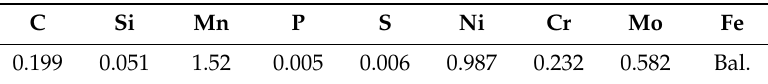
Table 1. Chemical composition of SA508 (wt.